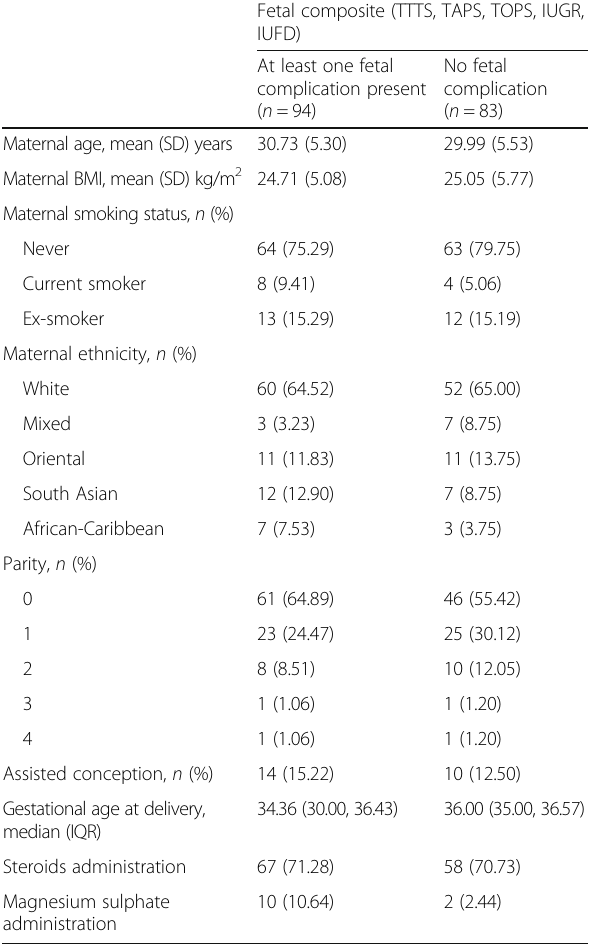
Table 1 Maternal characteristics used as adjustment factors